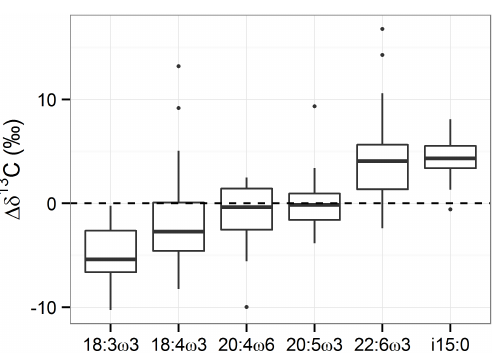
Figure 4. Box and whisker plots of the (cid:49)δ 13 C of individual biomarker fatty acids relative to 16:0 FA ( δ 13 C FA – δ 13 C 16 : 0 ) in all